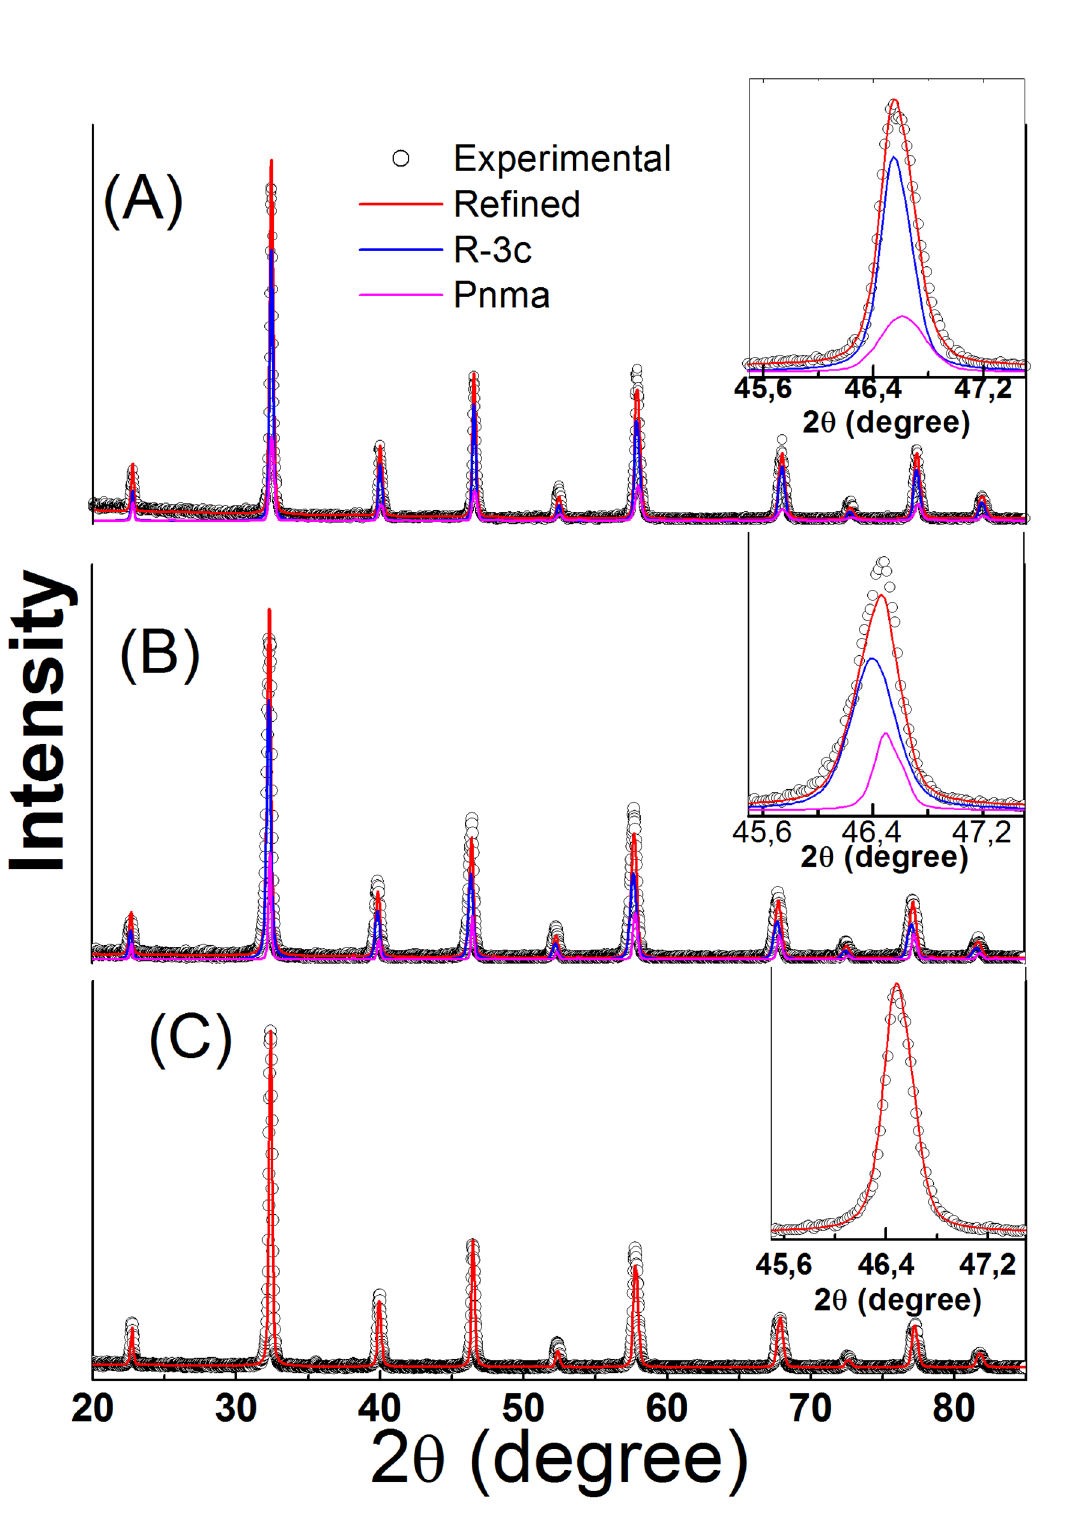
, LBM and LBM calcined at 1150 °C/10h. The open points and lines are experimental 3.7 6.2 8.7